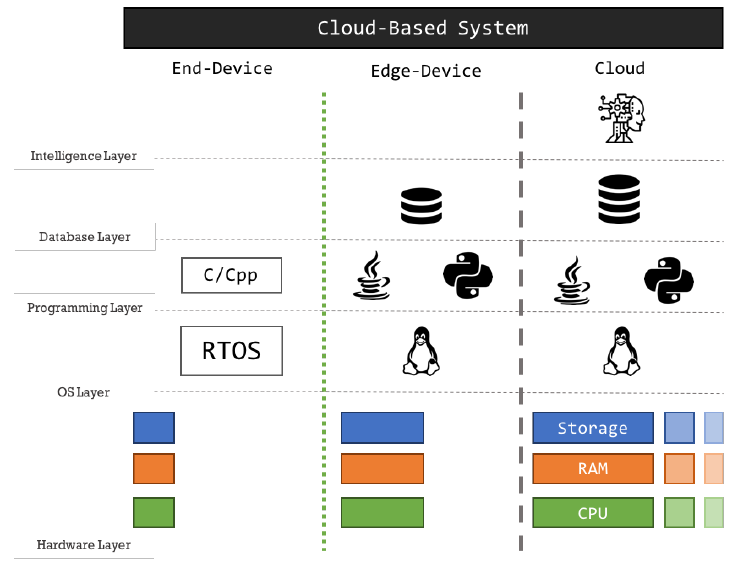
Figure 2. Cloud-based system depiction. In a Cloud-based system, the intelligence is entirely in the Cloud, where limitless RAM, memory storage, and CPU exist. The Cloud is responsible for data storage and processing. The high-level languages (e.g., Python or Java) are used to shorten the development time and to improve the system’s security. The edge-device is similar to the Cloud, however, its hardware resources are